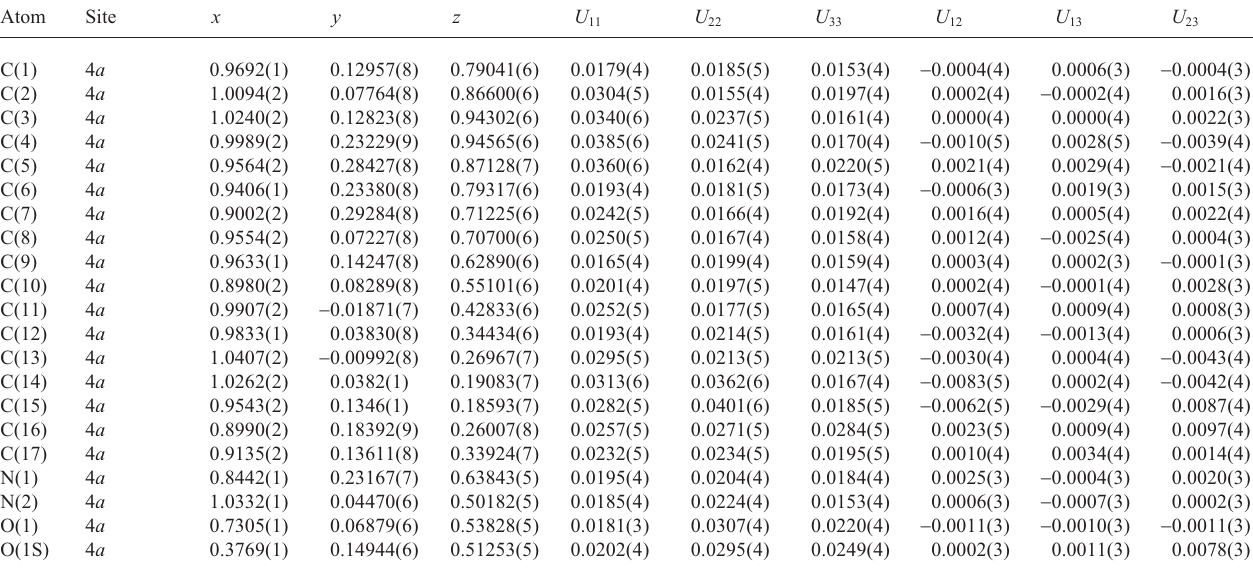
Table 3. Atomic coordinates and displacement parameters (in Å 2 )